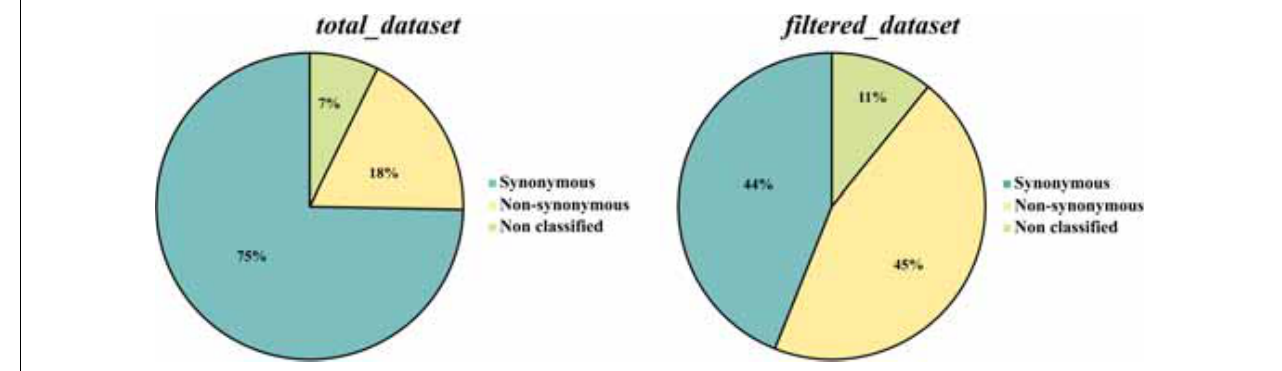
FIGURE 4 | Comparative analysis of the number of synonymous and non-synonymous SNPs in total_dataset and filtered_dataset.